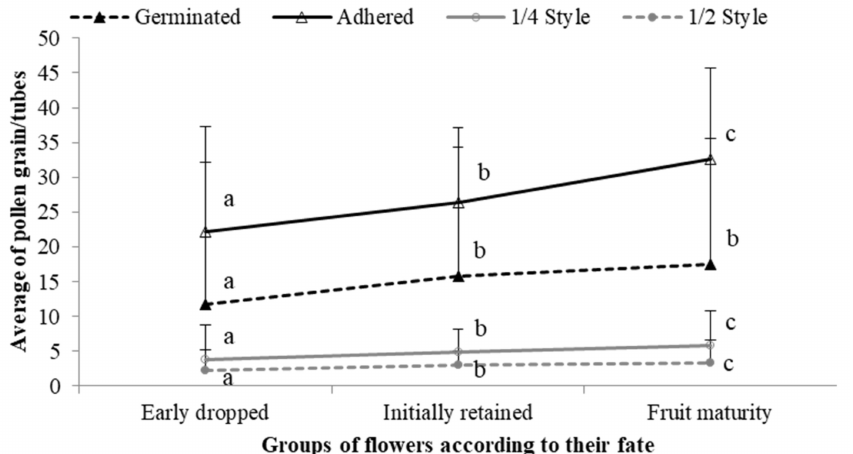
Figure 4. Pollen grains adhered and germinated and pollen tube number at the upper part of the style and at the middle of the style (where the styles were sliced) in avocado flowers. The values are presented as mean, and error bars are standard deviations. In the same dependent variable, the same letter indicates no significant differences ( p > 0.05, Tukey HSD